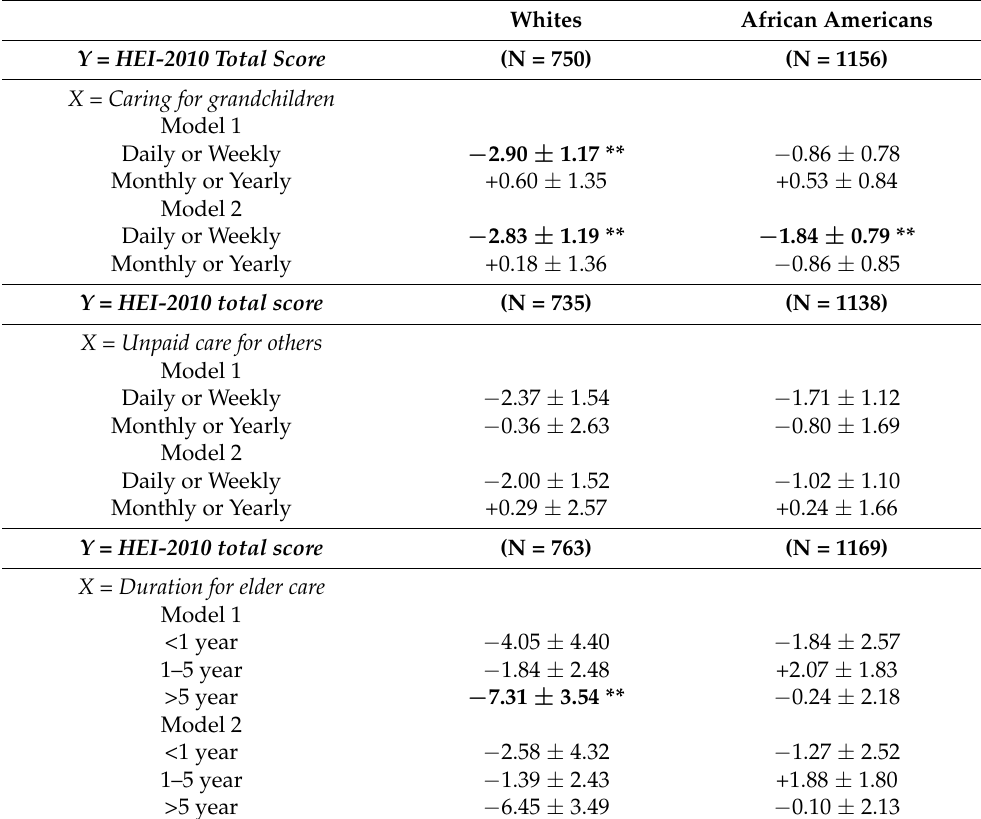
Table 3. Cross-sectional associations (Wave 4 only) between caregiving measures (recoded questions 3, 6 and 7/8) and diet quality measured with total HEI-2010 score ( β ± SE, p -value), stratified by race, for HANDLS participants: ordinary least square (OLS) linear regression 1